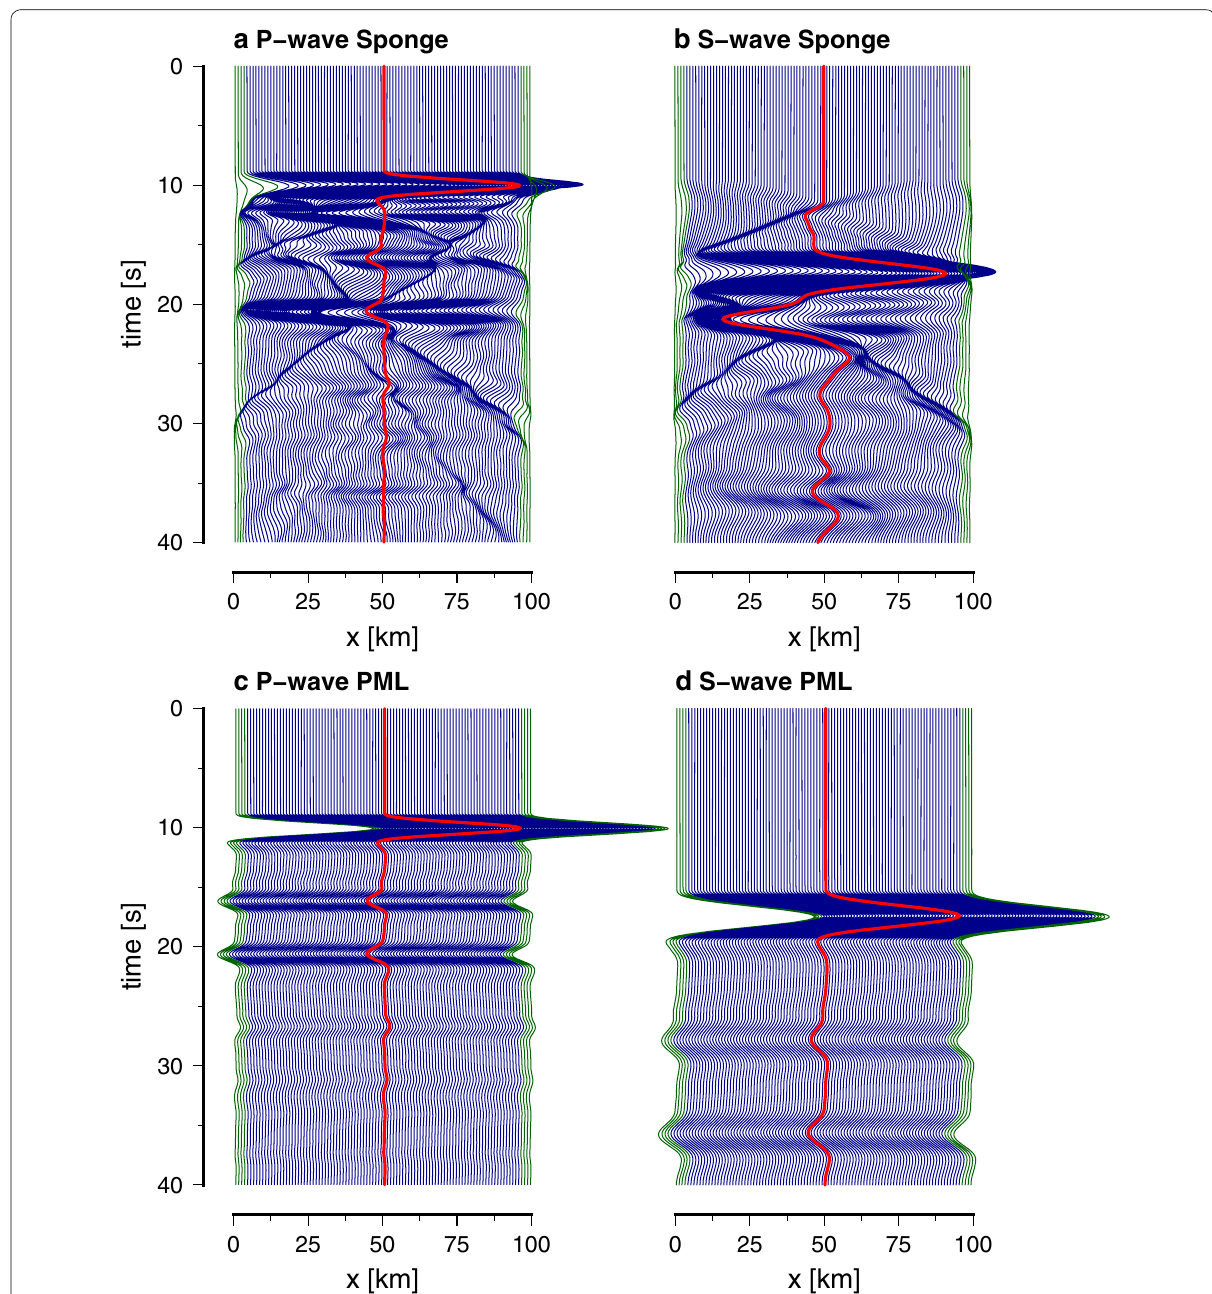
Fig. 15 The seismic traces for vertical plane-wave incidences obtained by the 2D P-SV simulations. a Vertical-component traces for P-wave inci- dence with the sponge boundary condition. b Horizontal-component traces for S-wave incidence with the sponge boundary condition. c, d same as a, b but with the PML boundary condition. Waveform traces within the absorbing layer are shown as green curves , and traces at the center of the model are shown as thick red